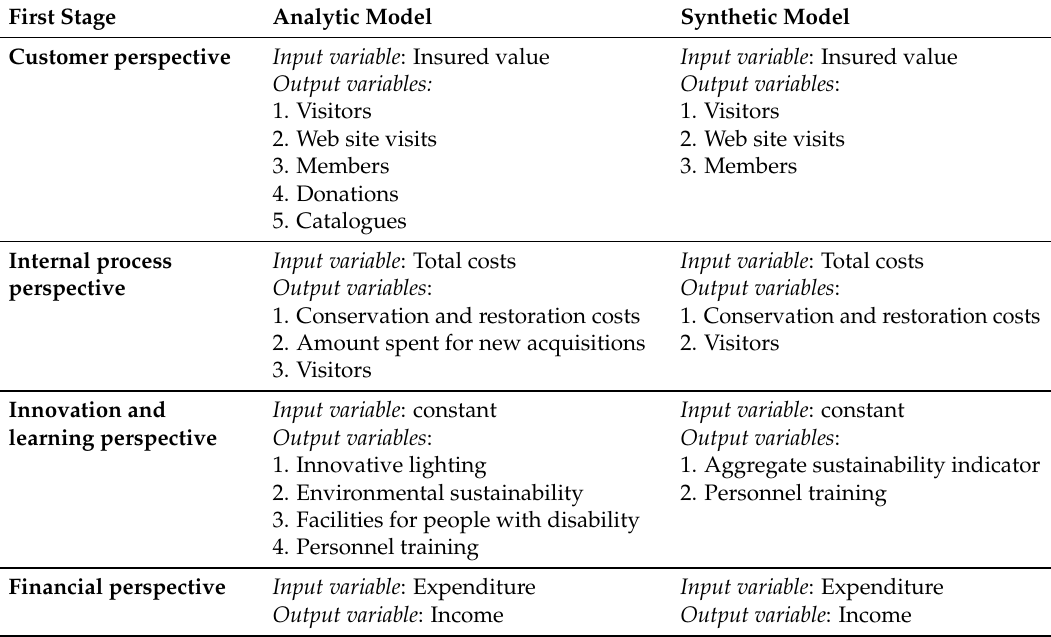
Table 1. Input and output variables of the first stage DEA-BSC